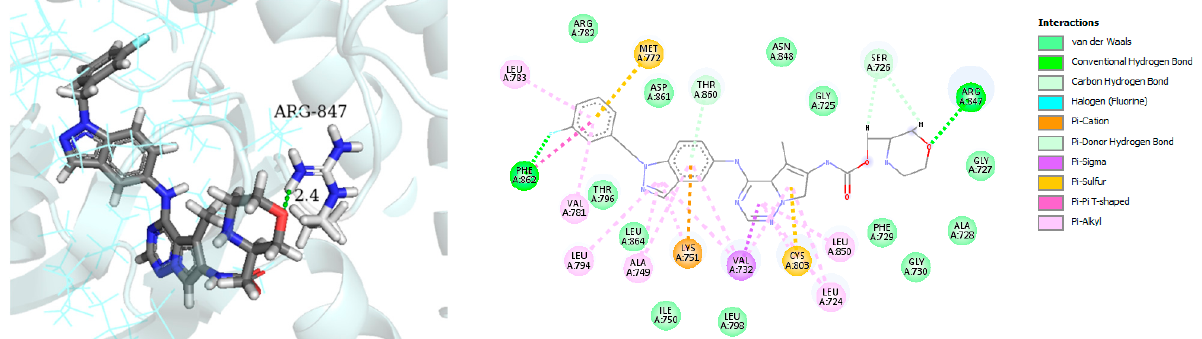
Figure 5. Best-docked pose of compound AC-480 within the HER4 (ErbB4) active site, where hydrogen bond interactions are shown as green dashed lines ( left panel ) and its corresponding detailed 2D-interactions map ( right panel ). This docking study was conducted by us, no copyright issues.